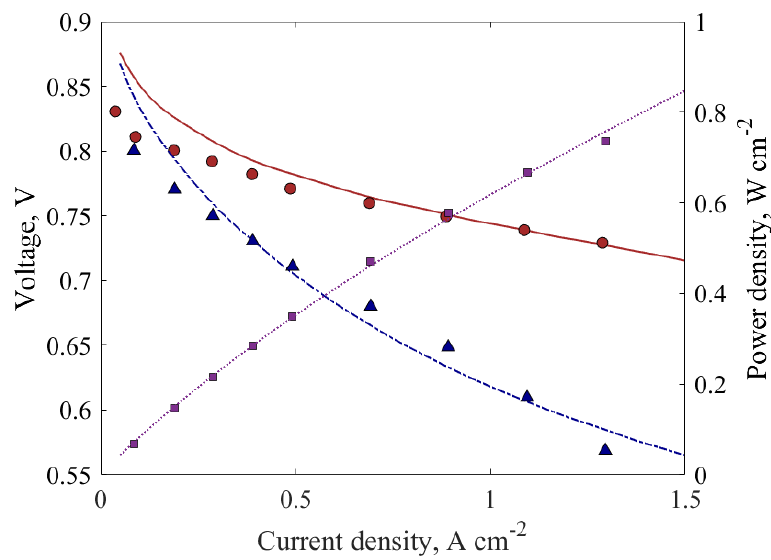
Figure 2. Polarization curves: [ ] is the experimental potential, [ ] is the iR-corrected experimental potential, [ ] is the experimental power density, [ — · ] is the predicted potential, [ — ] is the predicted iR-corrected potential, and [··· ] is the predicted power density.